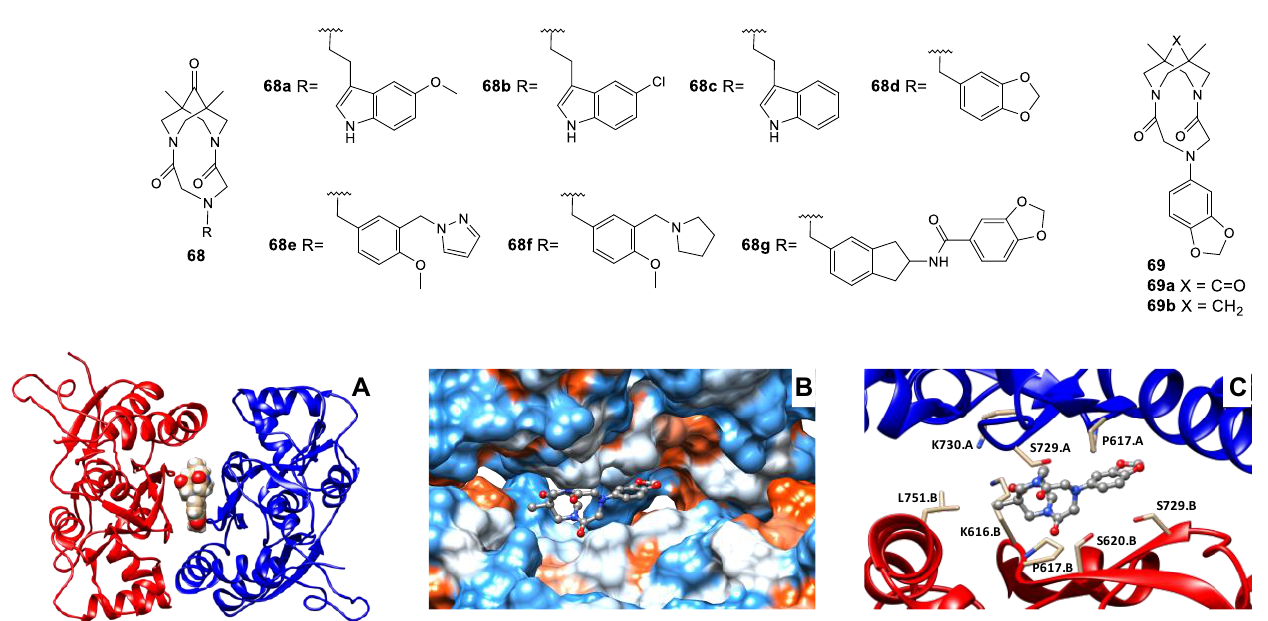
Figure 11. Possible binding mode of the modulator 69a in the PAM binding site refined using molecular dynamics simulation. ( A ) General view of the dimeric ligand-binding domain of AMPA receptor (GluA2) and location of the binding site. ( B ) Binding pockets in the protein molecular surface colored by local hydrophobicity (brown for hydrophobic and blue for hydrophilic). ( C ) Detailed view of the binding site. The ligand is represented by the gray ball-and-stick model, and the amino acid residues located within 3 Å of it are represented by beige stick models. Adapted with permission from Ref. [167]. Copyright 2022, Elsevier.